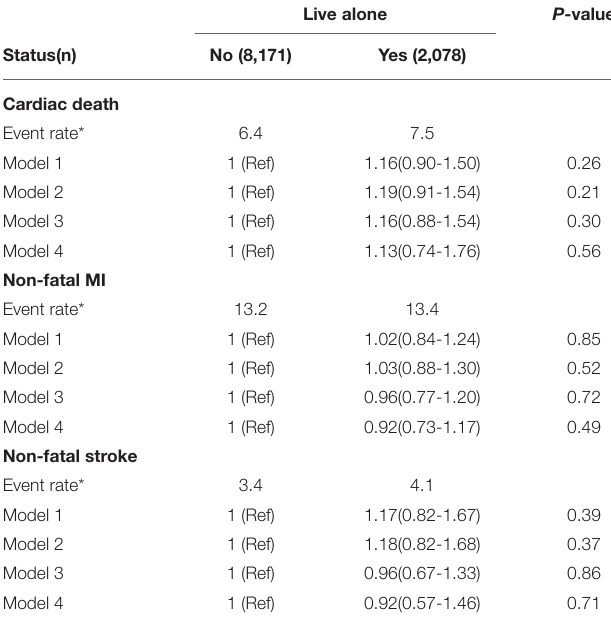
TABLE 3 | Association between living alone and individual components of MACEs.